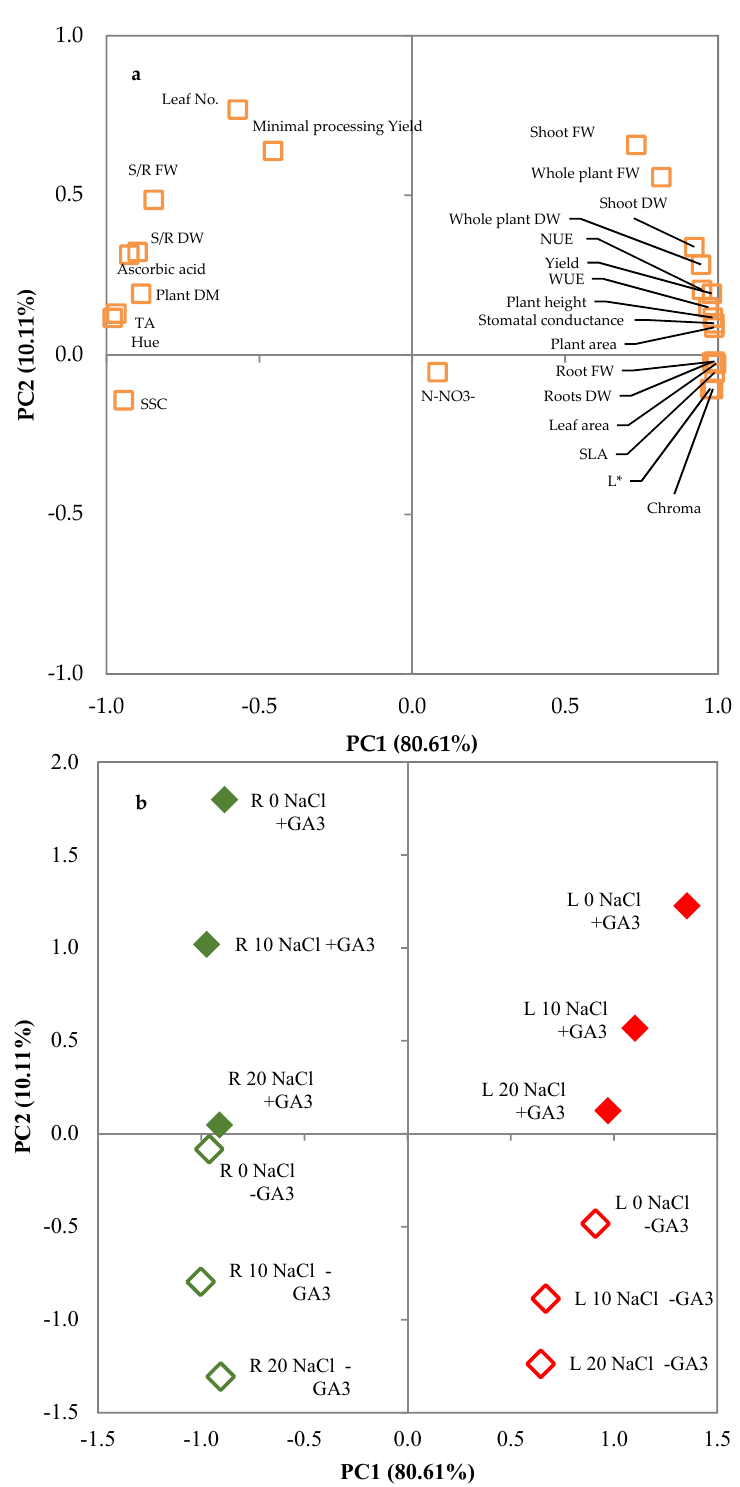
Figure 4. Plot of ( a ) loadings (morphophysiological and quality characteristics of lettuce and rocket plants) and ( b ) scores (trials) formed by the two principal components from the Principal Component Analysis (PCA). L: leaf lettuce plants; R: rocket plants; 0 NaCl, 10 NaCl, 20 NaCl: mM of NaCl in the nutrient solution; -GA3: nutrient solutions not supplemented with gibberellic acid; + GA3: nutrient solutions not supplemented with 10 − 6 M gibberellic acid.